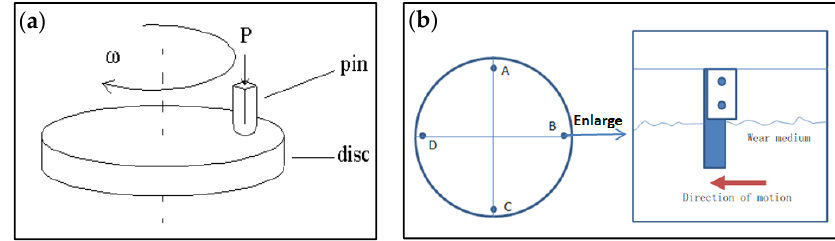
Figure 4. Wear form, ( a ) pin disc wear, ( b ) erosion wear.